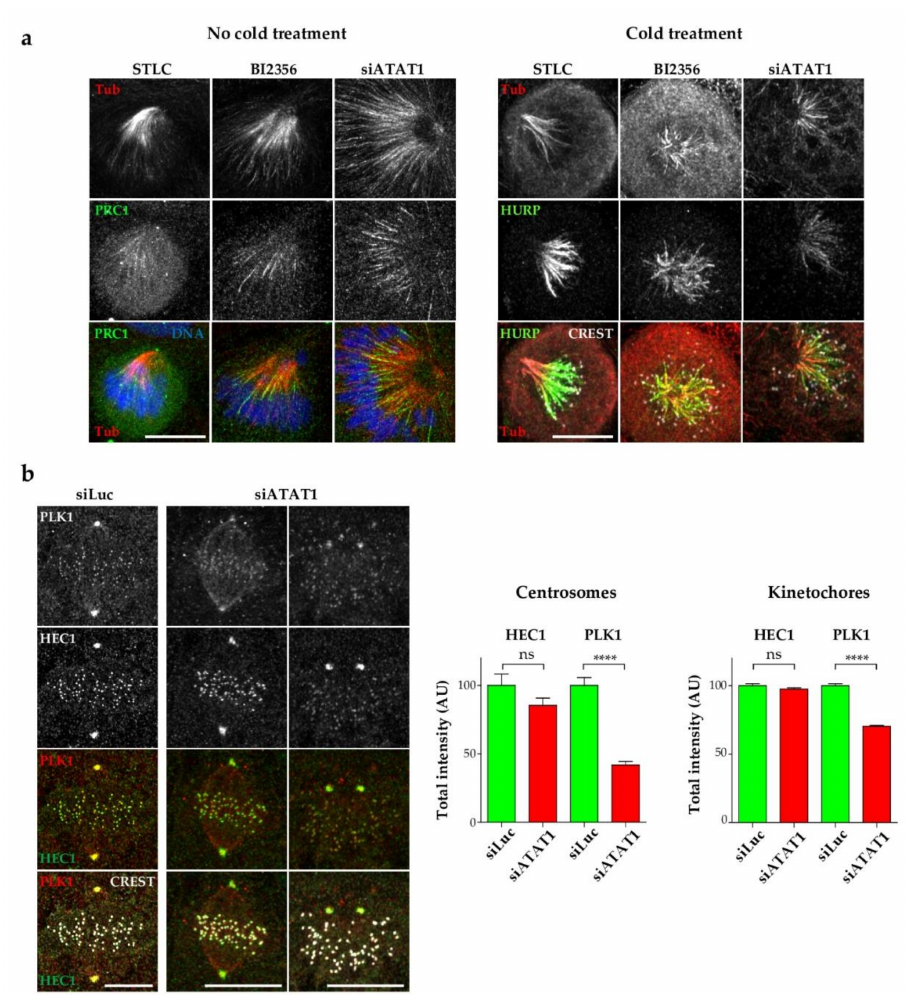
Figure 4. ATAT1 depletion affects PLK1 recruitment at centrosomes. ( a ) LLCPK1 cells were transfected for 48 h with siRNAs directed against luciferase or ATAT1 . SiLuc cells were treated after 24 h with STLC (2 µ M) for 24 h or after 46 h with BI2356 (100 nM) for 2 h. Cells were either fixed immediately (left panels) or after 1 h cold treatment (right panels) and processed for immunofluorescence. Left panels: Representative MIP images of monopolar spindles (resulting from STLC, BI2356 or si ATAT1 treatments) stained for tubulin, PRC1 and DNA. Scale Bar is 10 µ m. Right panels: Representative MIP images of the monopolar spindles, after 1 h cold treatment, stained for tubulin, the K-fiber marker HURP and DNA. Scale bar is 10 µ m. ( b ) LLCPK1 cells transfected for 48 h with siRNAs directed against luciferase or ATAT1 were fixed and stained for PLK1 , HEC1 , and CREST. Representative MIP images of an siLuc metaphase spindle and si ATAT1 bipolar and monopolar spindles are shown. Quantification of total HEC1 and PLK1 intensities at centrosomes and at every kinetochore was performed on 3D stack images using Imaris software. At least 25 centrosomes and 700 kinetochores were analyzed per condition and per experiment ( n = 3). p < 0.0001 is considered highly significant and noted in the graphs with